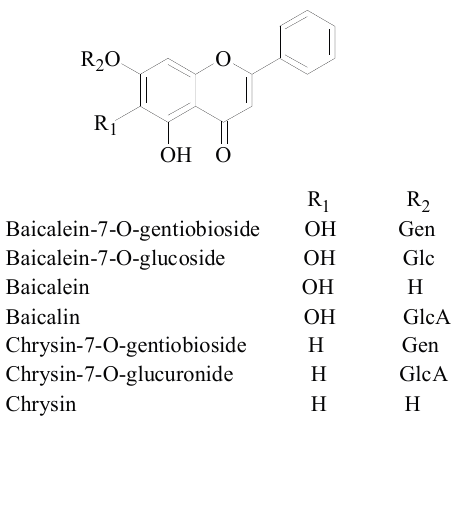
Figure 1. Structures of the seven major flavonoids detected in Semen